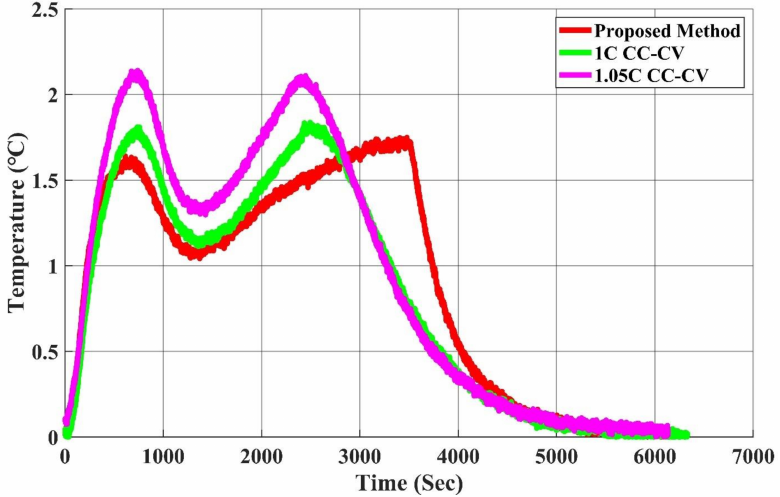
Figure 13. Comparison of the temperature rise waveforms of different charging